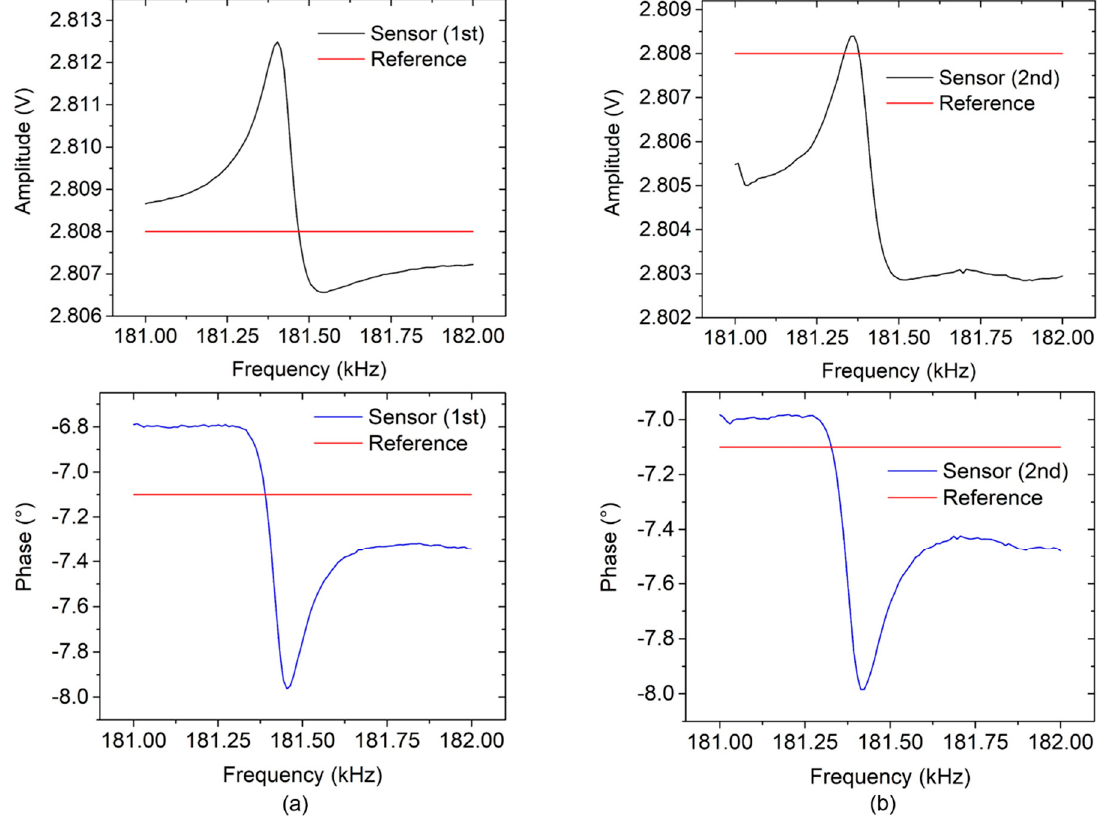
Figure 15. ( a ) Ideal configuration between sensor and reference signals for optimizing its phase response, while in ( b ) it is not ideal. For both operating conditions, the same reference signal is used.